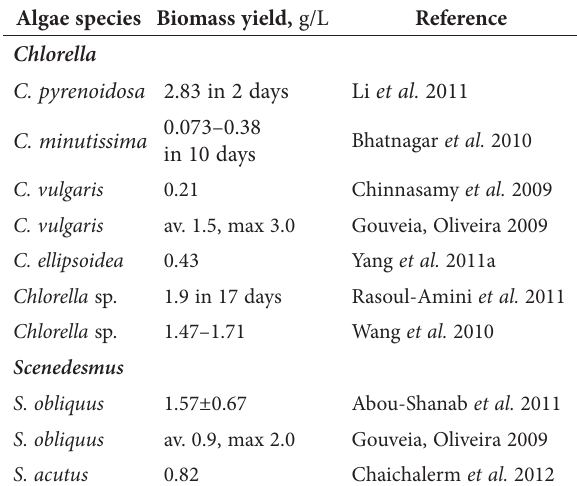
Table 1. Physico-chemical parameters of municipal wastewater collected from Vilnius wastewater treatment plant Contaminants